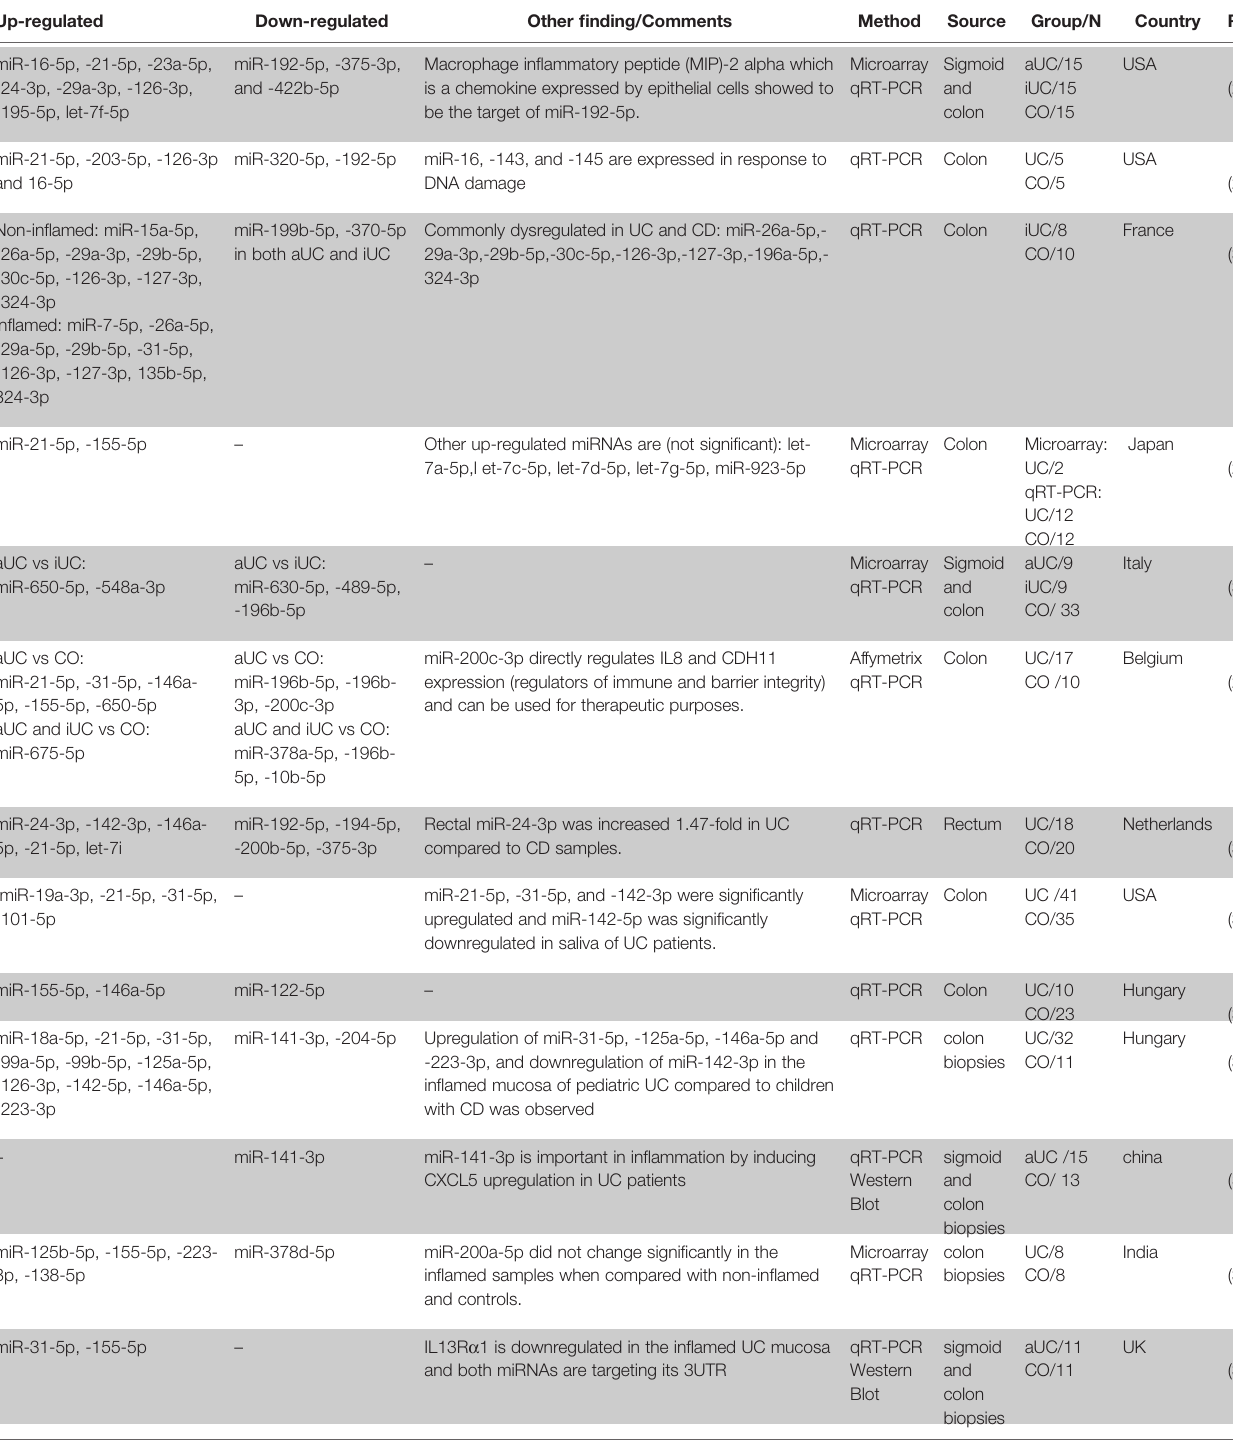
TABLE 1 | Differentially expressed miRNAs in human UC colonic tissue based on literature